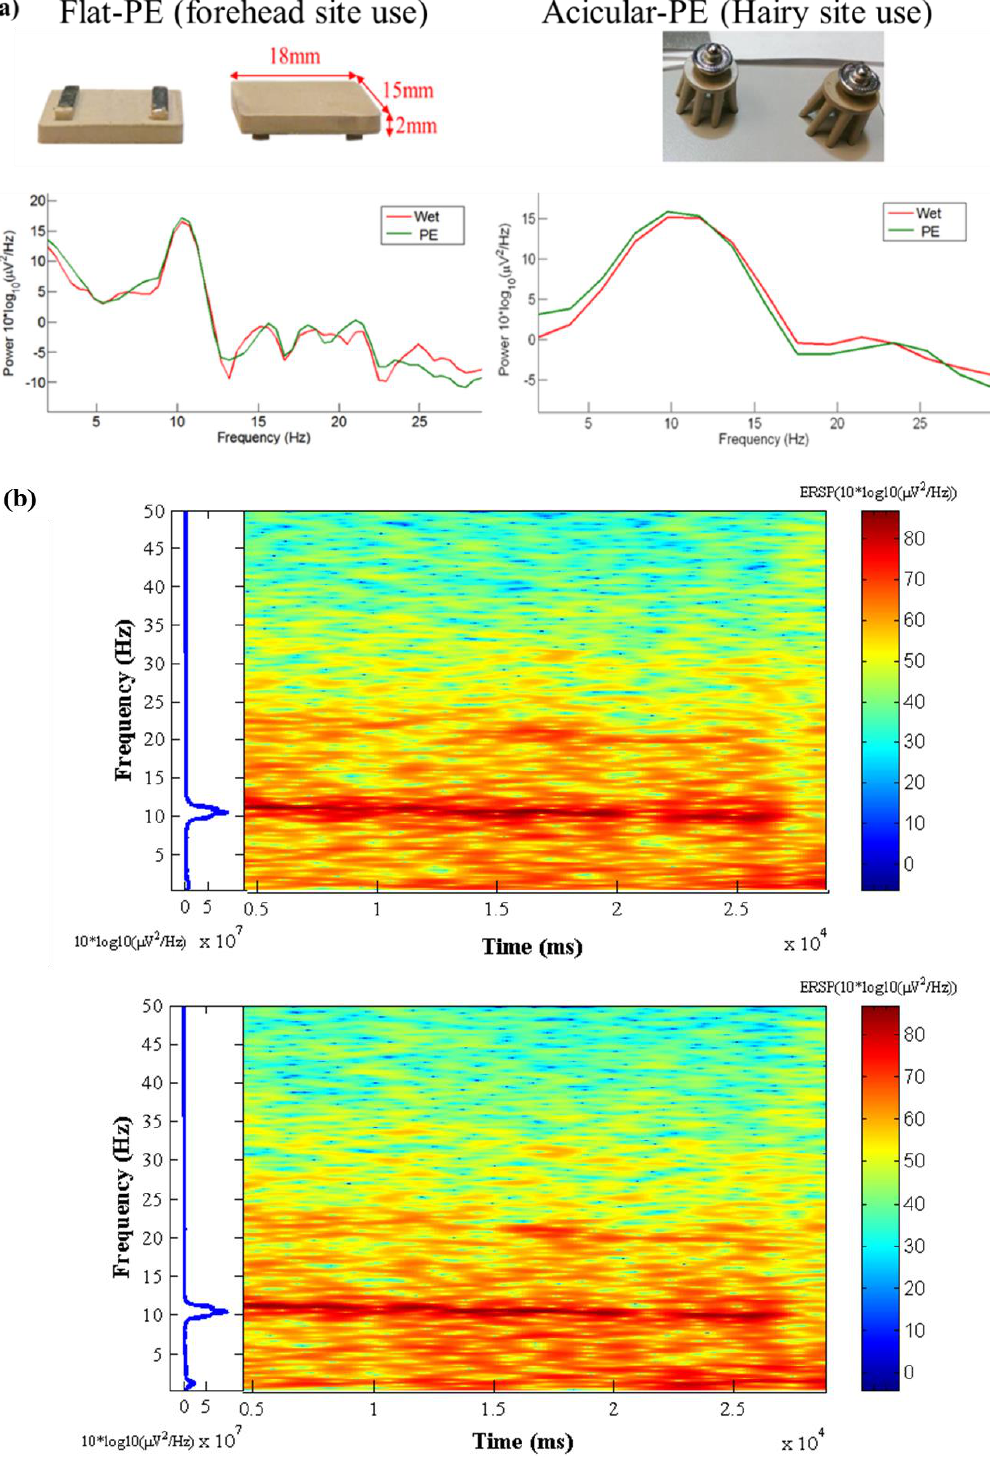
Figure 9. ( a ) Alpha rhythm tests. The left diagram is the forehead EEG data and the right is the occipital EEG data. Wet sensors were located at Fp1and Oz and the proposed dry PEs were located near Fp1 and Oz; ( b ) Time-frequency analysis of the EEG signals (Oz) for 0~50 Hz spectrum. The top diagram is the wet sensor’s result located at Oz, and the bottom diagram is the proposed PE’s result located near Oz.